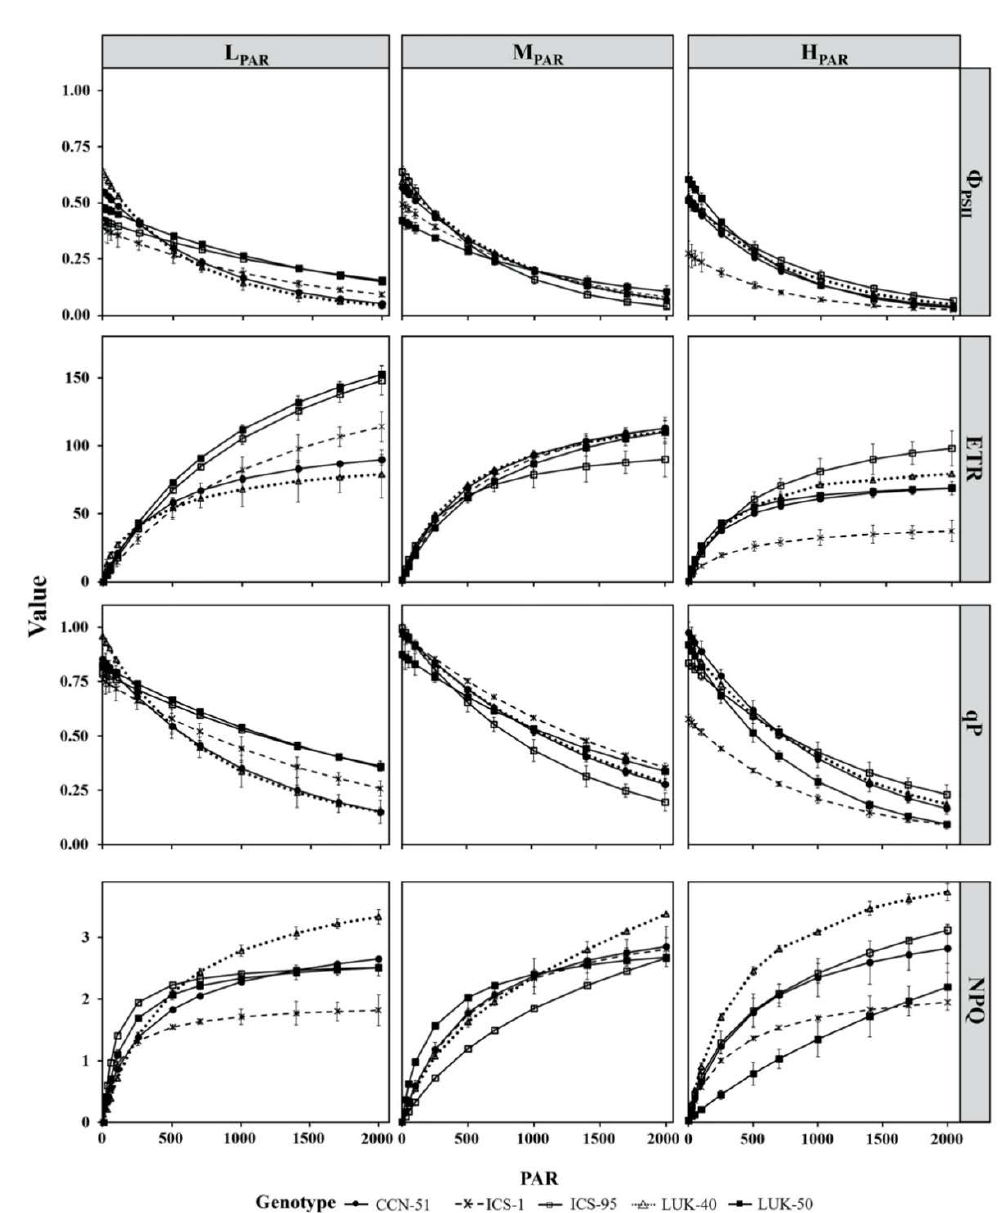
Figure 5. Chl fluorescence parameters in relation to PAR levels in cacao leaves for five genotypes of cacao in three radiation levels. Actual PSII quantum yield (ΦPSII); electron transport rate (ETR); photochemical quenching coefficient (qP); non-photochemical quenching coefficient (NPQ). The results include means ± SE ( n = 4). Statistics are defined as in Figure 1.